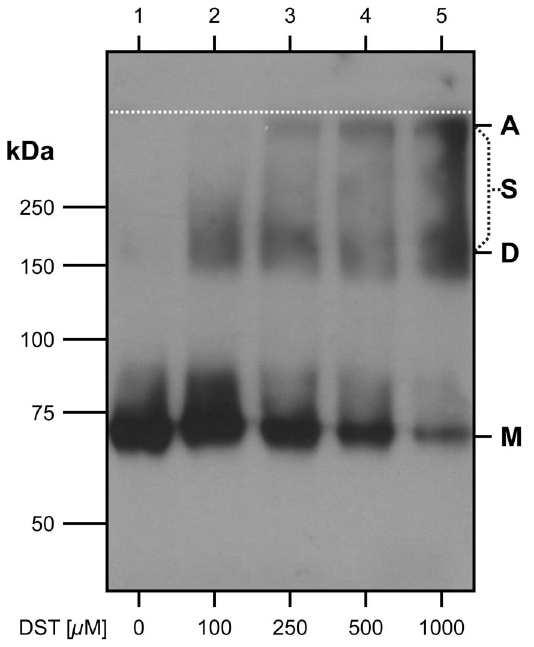
Figure 4. Chemical crosslinking of hSVCT1 in isolated oocyte membranes. Western blot analysis of isolated oocyte membranes containing hSVCT1 incubated at different DST concentrations, i.e., 0, 100, 250, 500 and 1000 m M. hSVCT1 monomer ( M ), dimer ( D ) and aggregate ( A ) bands are indicated. At $ 250 m M DST increasing smearing ( S ) and aggregation, and decreasing amounts of monomers are observed indicating unspecific crosslinking. Western blotting was performed using a 6% SDS/polyacrylamide gel and an anti-HA antibody. The interface between stacking and separating gels is indicated (dotted, white